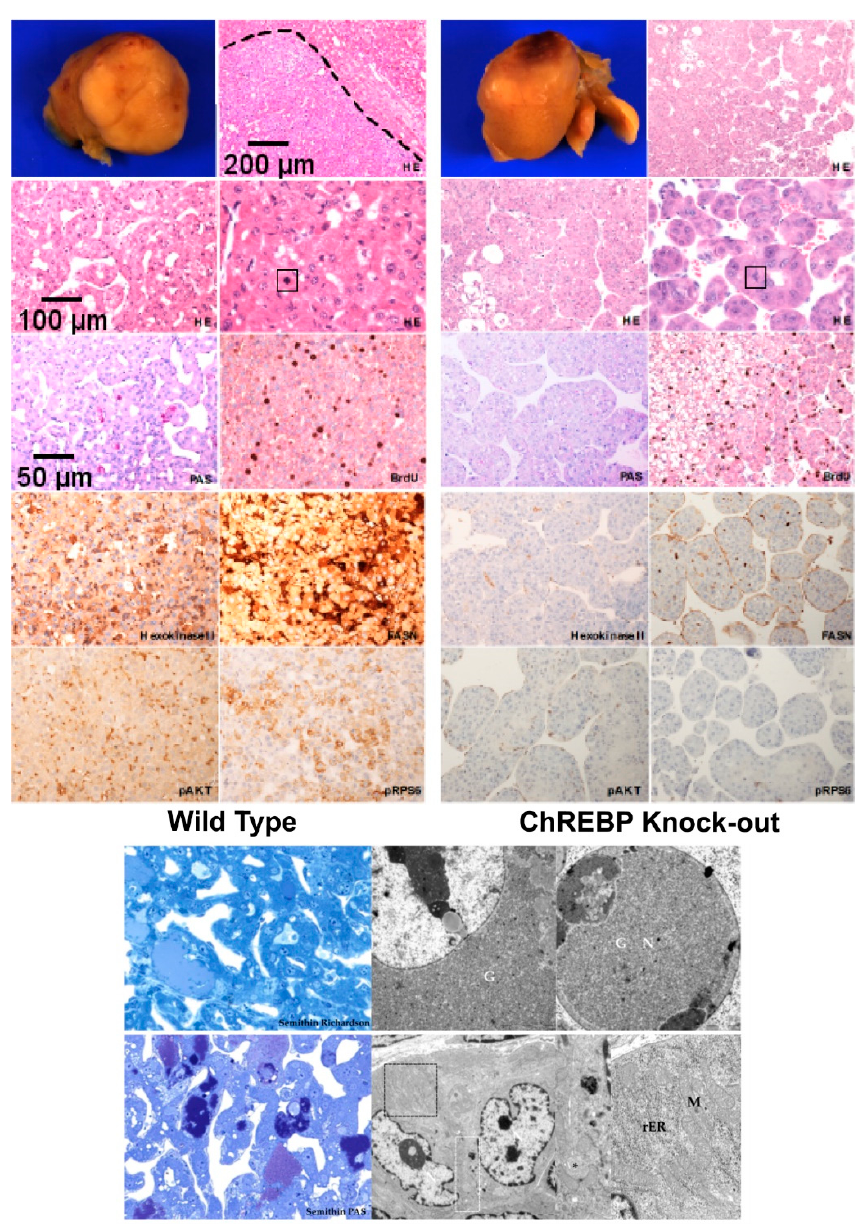
Figure 4. HCCs of WT mice are associated with enhanced glycolytic, de novo lipogenesis and AKT/mTOR pathway activities.